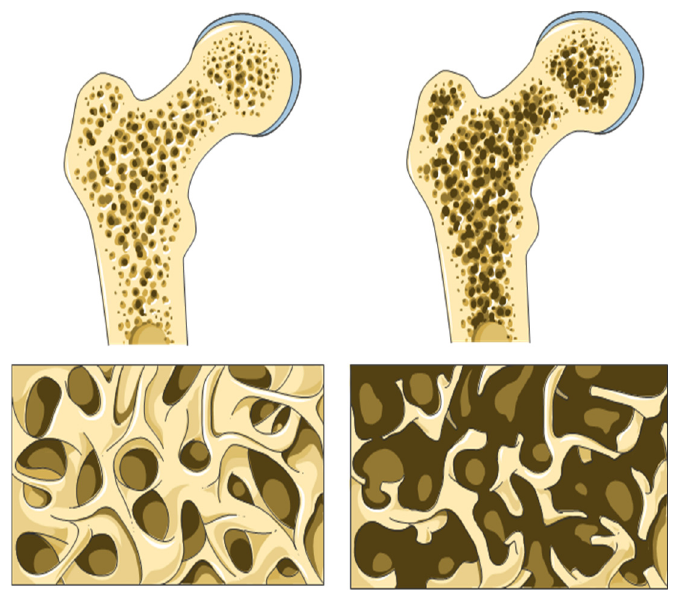
Figure 2. Left: Schematic structure of a healthy bone; dense and loadable bone structure. Right: Schematic structure of an osteoporotic bone; decreased bone mass and pathological changes in microarchitecture. © 2016 Laboratoires Servier [62]